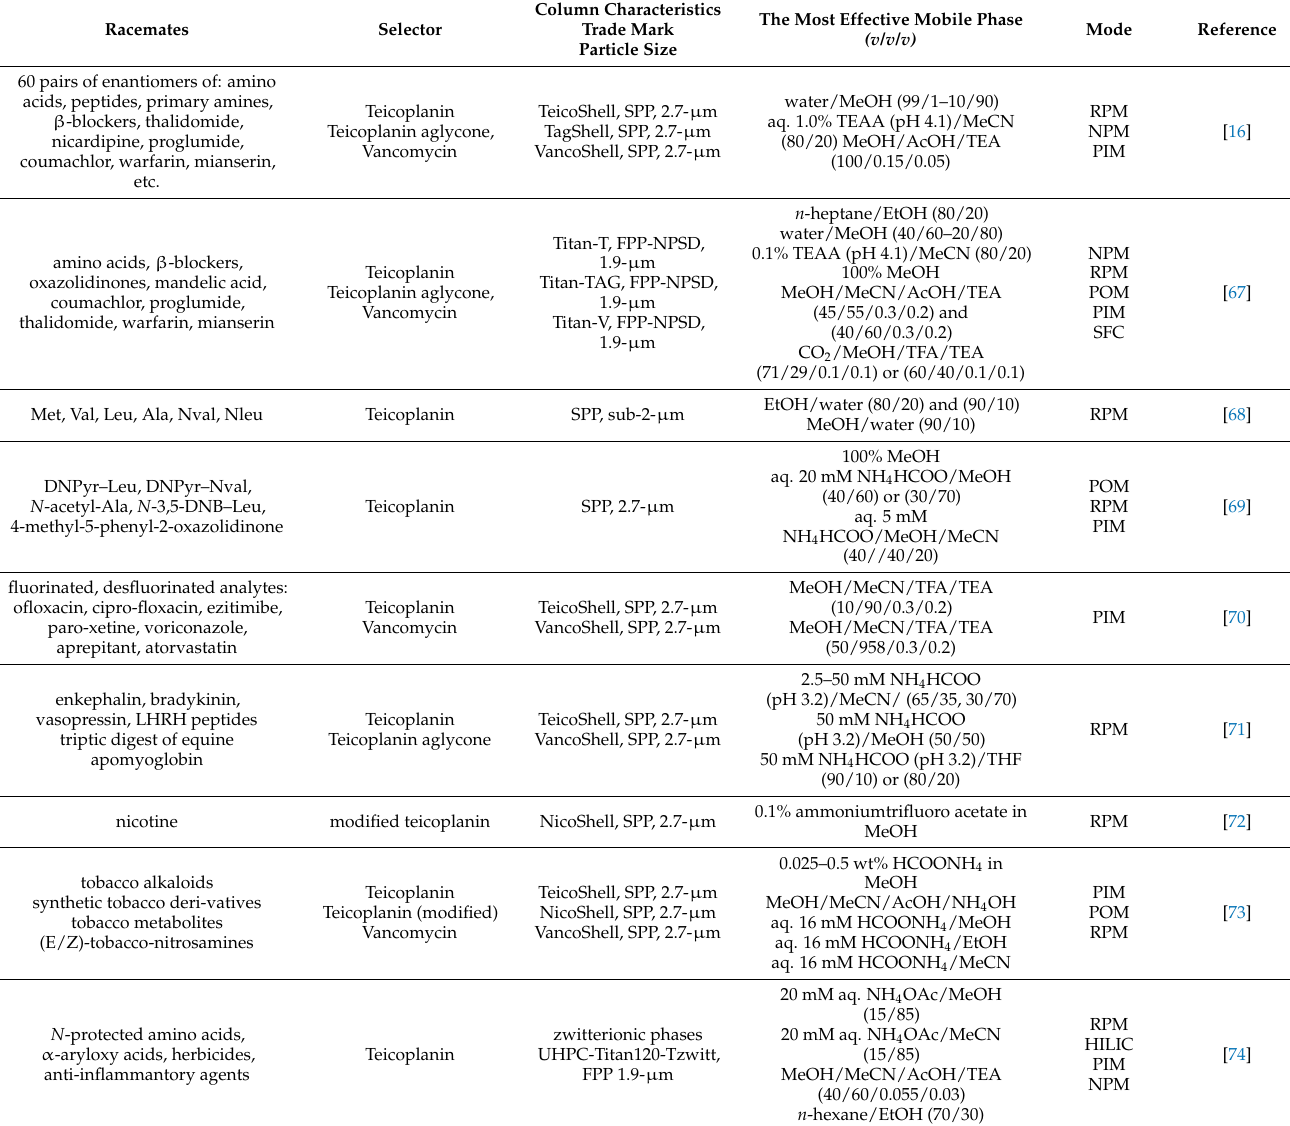
Table 5. Ultra-high-performance liquid chromatographic enantioseparations of different analytes on macrocyclic glycopep- tide selectors immobilized on sub-2 µ m superficially porous (core-shell) and fully porous particles. Column Characteristics The Most Effective Mobile Phase Racemates Selector Trade Mark (v/v/v) Mode Particle Size